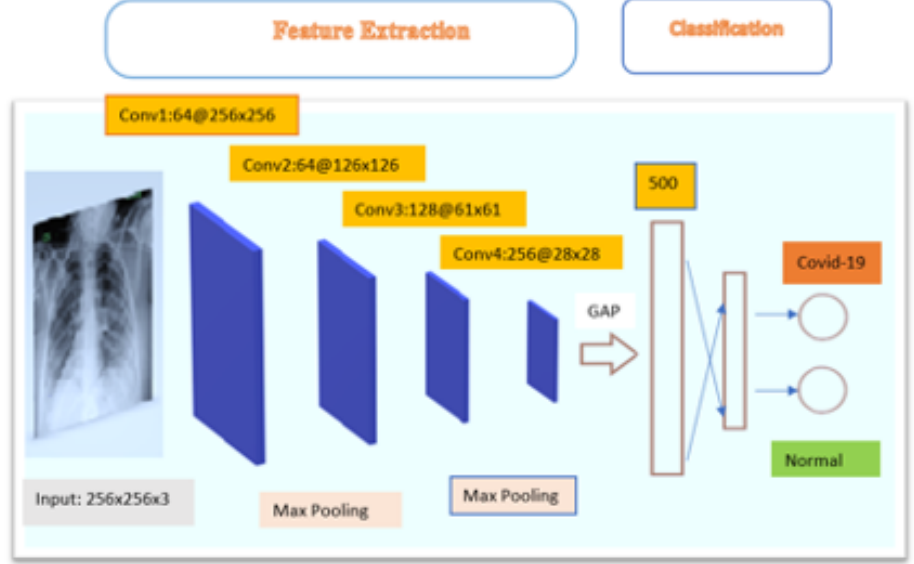
Figure 4. The proposed structure of